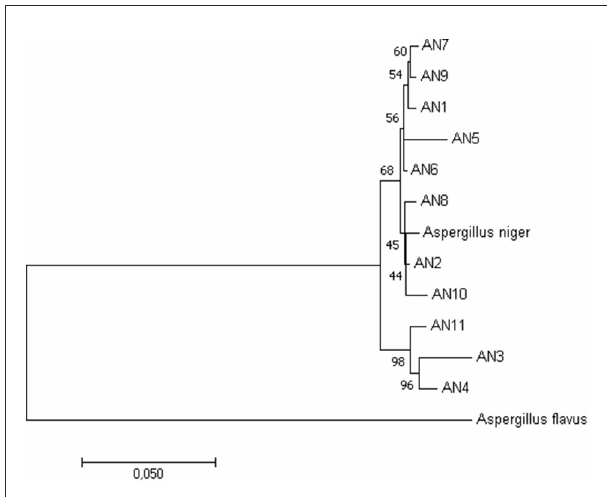
FIGURE2 Phylogenetic relationship among A. niger isolates based on ITS, β -tubulin, and calmodulin genes by the Maximum Likelihood method. Bootstrap analysis was done with 1,000 replicates and values at nodes of branches refer to the number of times (%) the branching is supported.